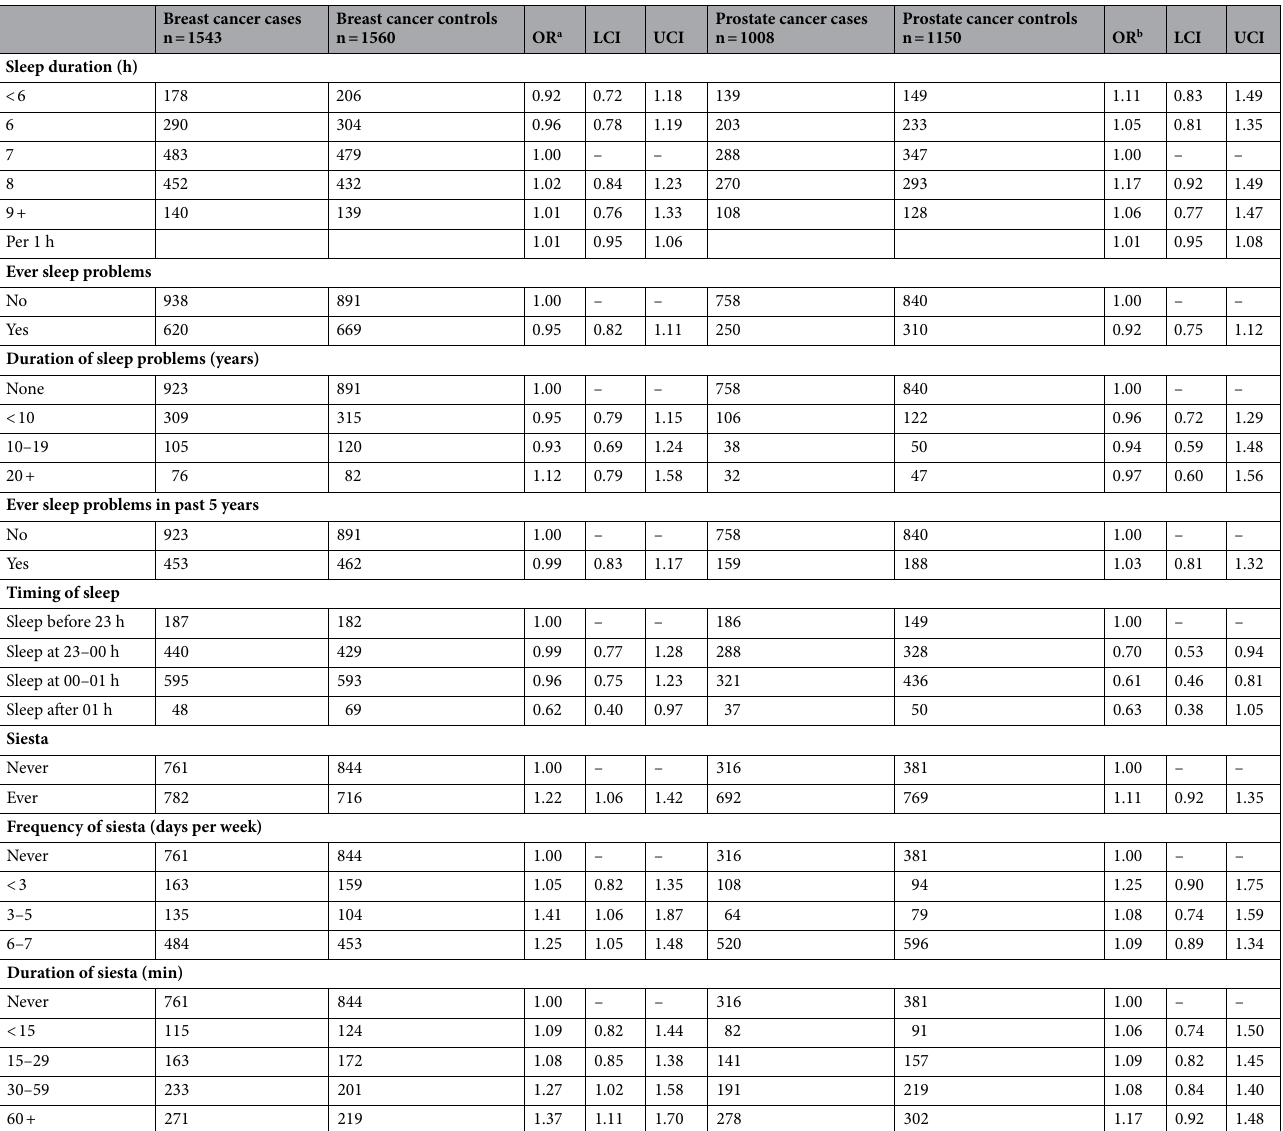
Table 2. Associations of various habitual sleep characteristics and breast and prostate cancer risk, MCC- Spain, 2008–2013. Note the sum does not equal the total due to missing data. a Models adjusted for age,